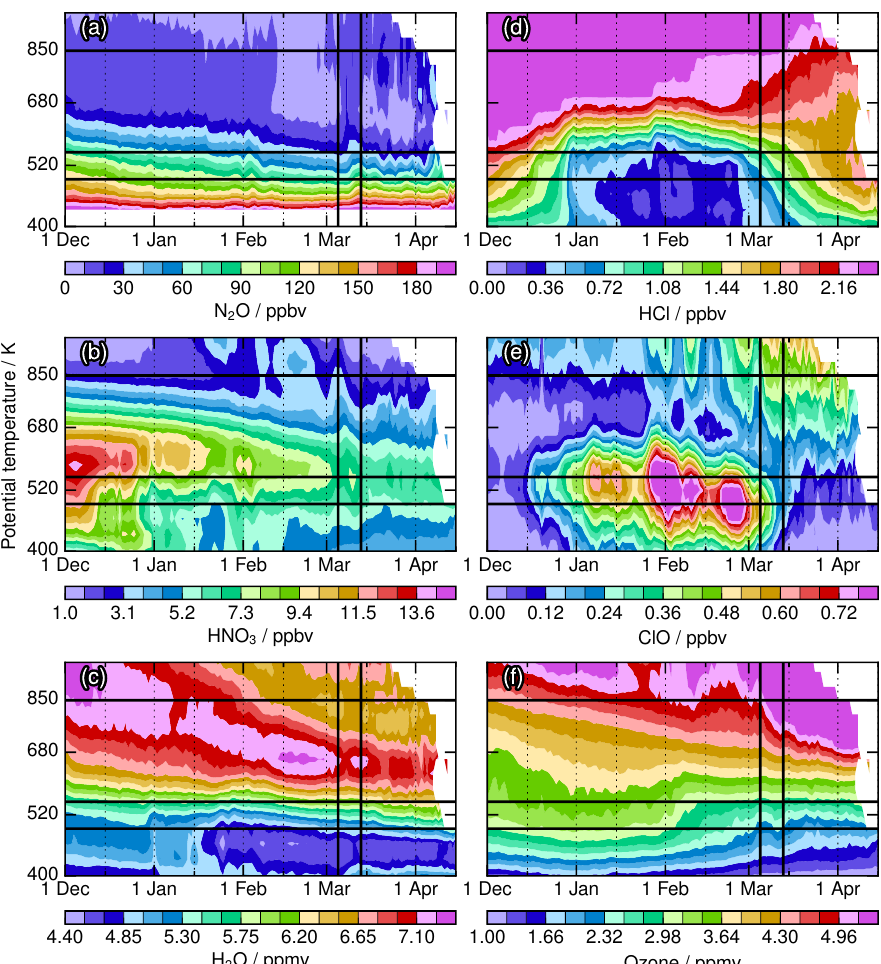
Figure 4. Potential temperature/time series of vortex-averaged (the sum of all regions identified by CAVE-ART using the 84 ◦ EqL threshold) MLS trace gases during the 2015/16 winter showing N 2 O (a) , HNO 3 (b) , H 2 O (c) , HCl (d) , ClO (e) , and ozone (f) . Horizontal black lines indicate 490, 550, and 850K, the primary levels we focus on in this paper. The two black vertical lines indicate the SSW onset and the ensuing vortex split. Version 4 MLS N 2 O at 100hPa shows unphysical biases (Livesey et al., 2015a); N 2 O values below 430K, where 100hPa starts to significantly influence the vortex average, are thus not